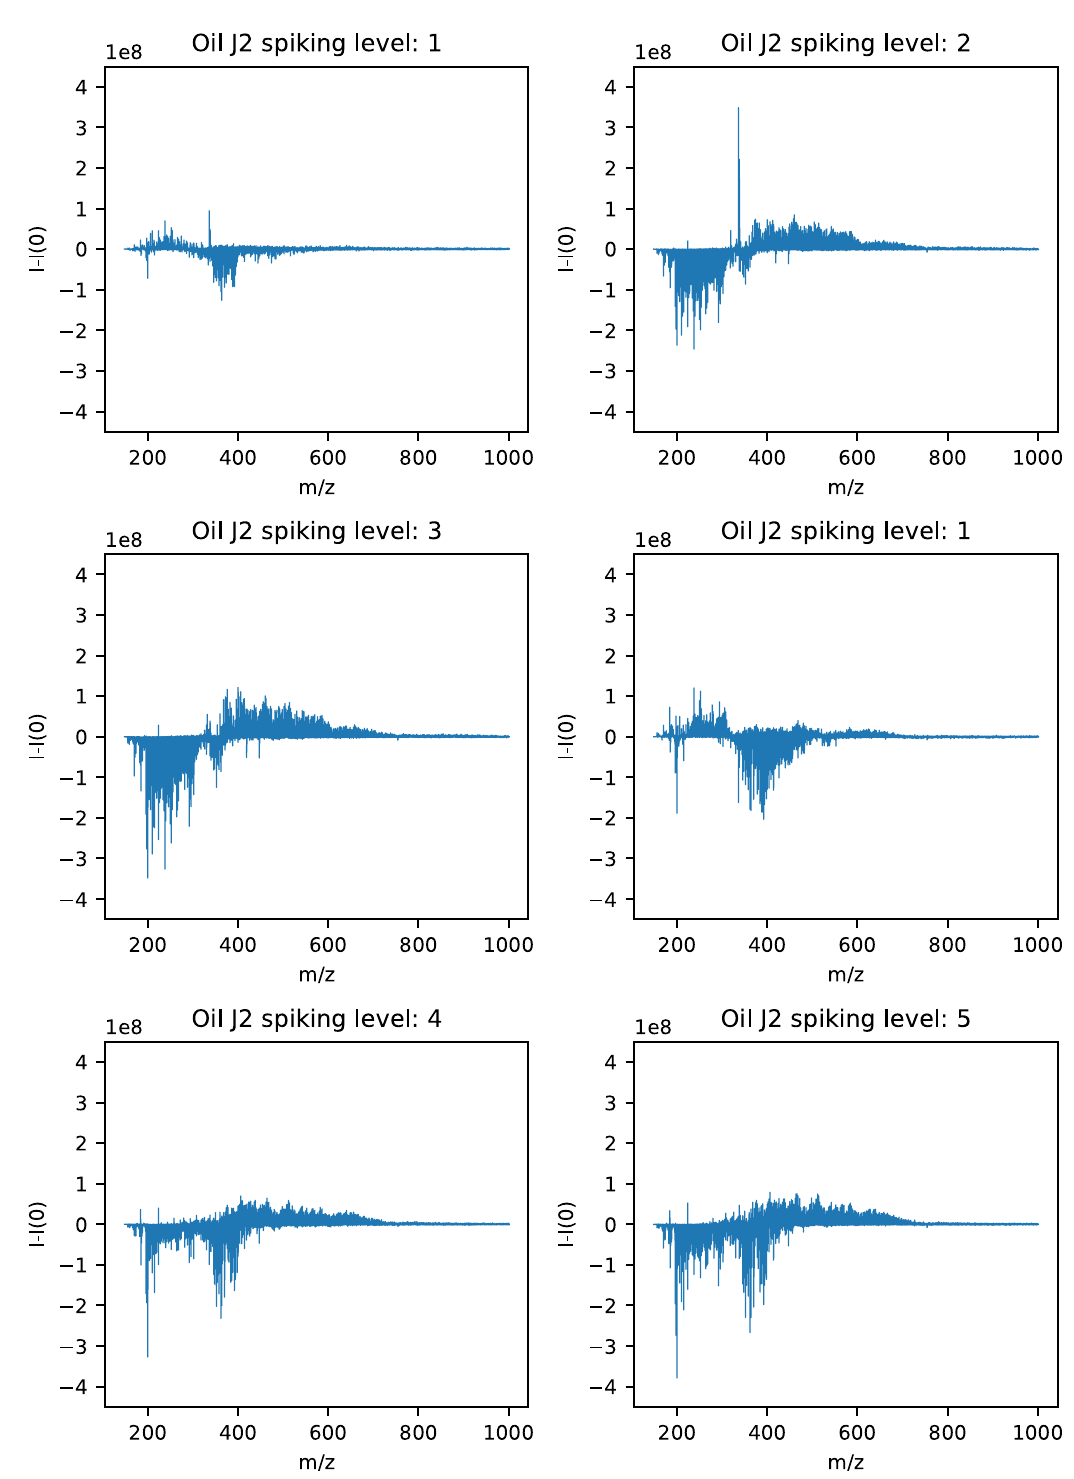
Fig 5. Mass spectra of samples from the hydrate phases for oil J2 with spiking level 0 subtracted from each of the spiking levels 1–5.